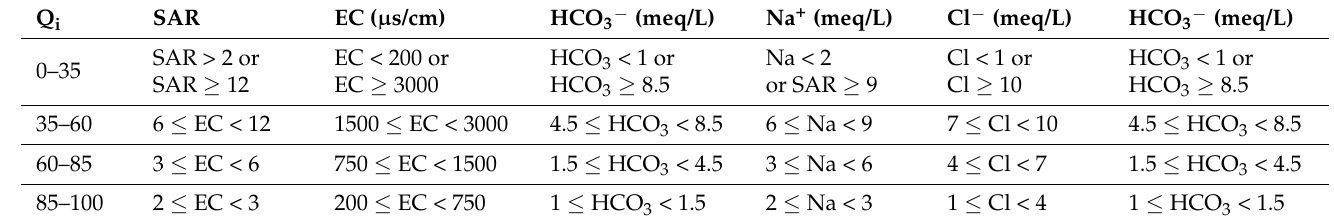
Table 2. The range of limit values of the parameters used in the computation of quality measure- ment